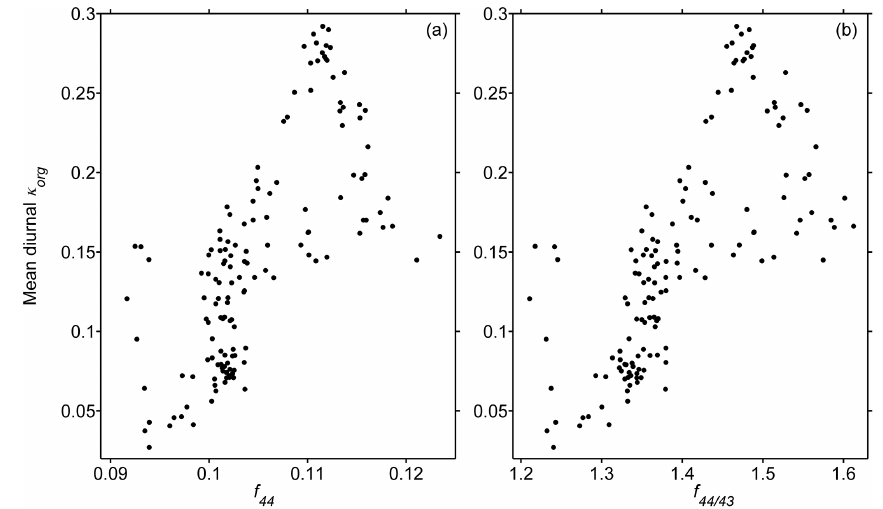
Figure 9. Relationships between the mean diurnal κ org results vs. (a) f 44 and (b) f 44 / 43 in NR-PM 1 haze particles. Mean diurnal here represents that the diurnal results for each day were further averaged over the overlapping observation period, i.e., with both HTDMA and ToF-ACSM measurements taken from 10 to 24 October